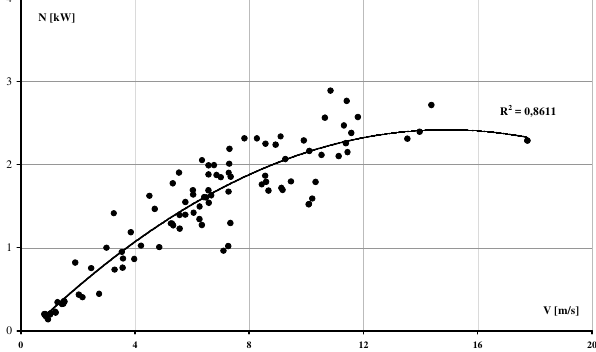
Fig. 7. The relationship between the average braking power and the aver- age car speed